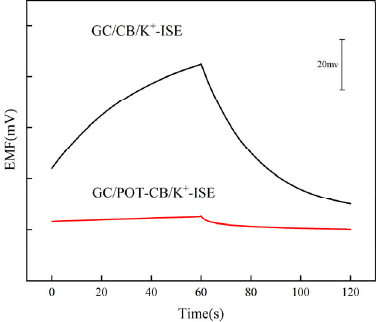
5 of 11 Figure 3. ( a ) Potential response diagram of GC/POT − CB/K + − ISE in KCl solution; ( b ) potential cali- bration curve of GC/POT − CB/K + − ISE.The red line is the linear fi tt ing line of the electrode in the range of 10 − 6 − 10 − 1 M 2.4. Reverse Chronopotentiometric Measurement Reversed − current chronopotentiometry is used to evaluate the capacitance of the solid − state ion selective electrode and the short − term potential stability of the developed electrode. In this work, reverse current chronopotentiometry was used to characterize the short − term potential stability of GC/POT − CB/K + − ISE. Figure 4 shows the typical chronopotentiometric curve of GC/POT − CB/K + − ISE. From the same experimental dia- gram, the short − term stability of the potential can be derived from the ratio Δ E/ Δ t. The calculated potential drift value of GC/POT − CB/K + − ISE is about 10.9 ± 0.5 µV/s, far lower than the value of GC/CB/K + − ISM (820.6 ± 46.8 µV/s). According to the equation Δ E/ Δ T = I/C (C, low frequency capacitance), the capacitance of the solid contact layer is estimated